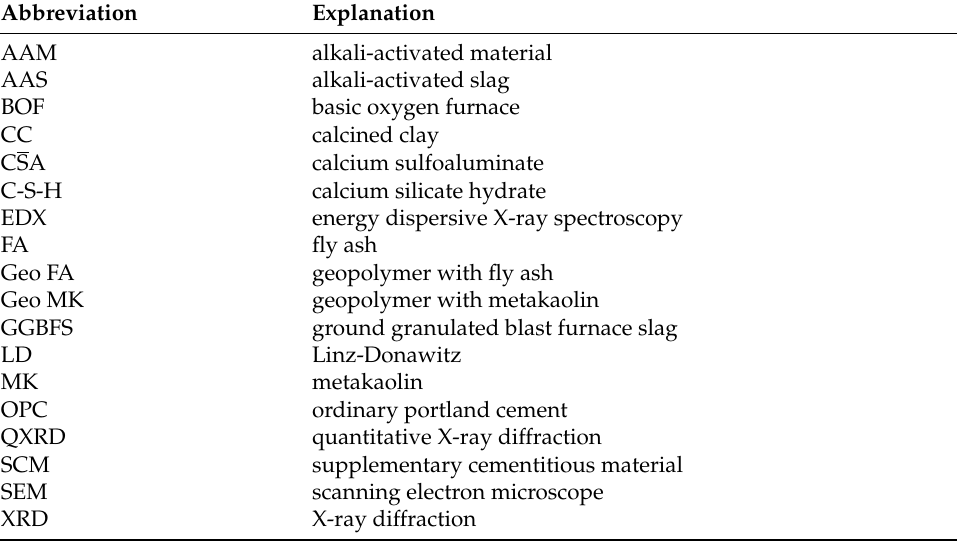
Table A1. List of